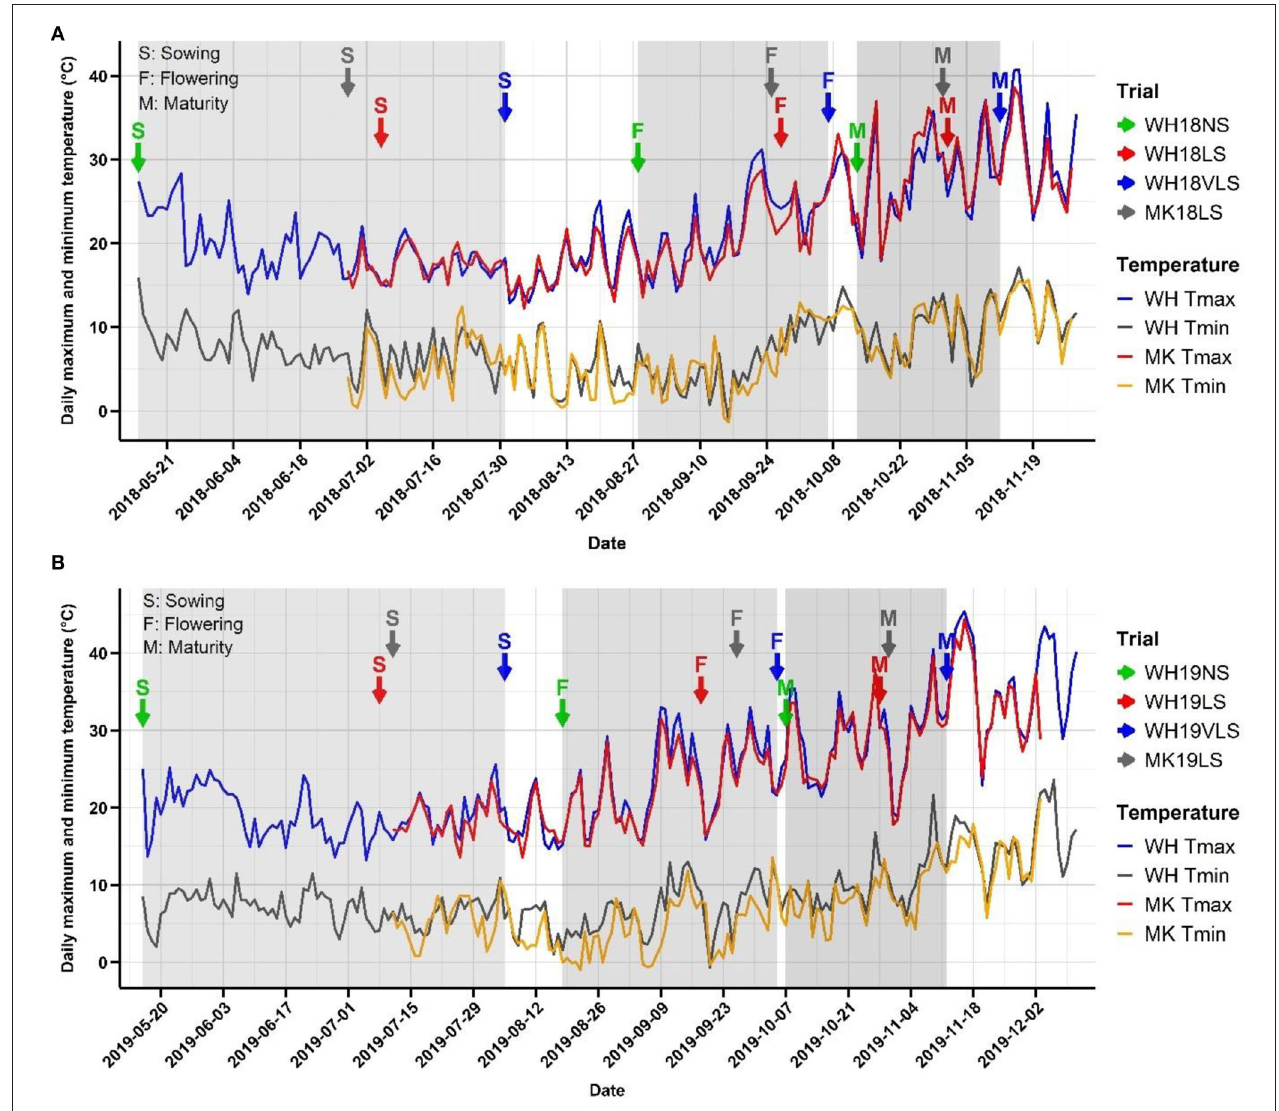
FIGURE 1 | Minimum and maximum temperatures experienced in each trial at Wongan Hills (WH) and Muresk (MK) in (A) 2018 and (B) 2019 crop growing seasons. The time series line plots in blue and grey, and red and orange indicate the daily maximum and minimum temperature at WH and MK, respectively. The arrows in green, red, and blue colours indicate normal (NS), late (LS), and very late sown (VLS) trials at WH, respectively, and the grey arrows indicate LS trials at MK. S, F, and M indicate sowing, average flowering, and physiological maturity dates in each trial,